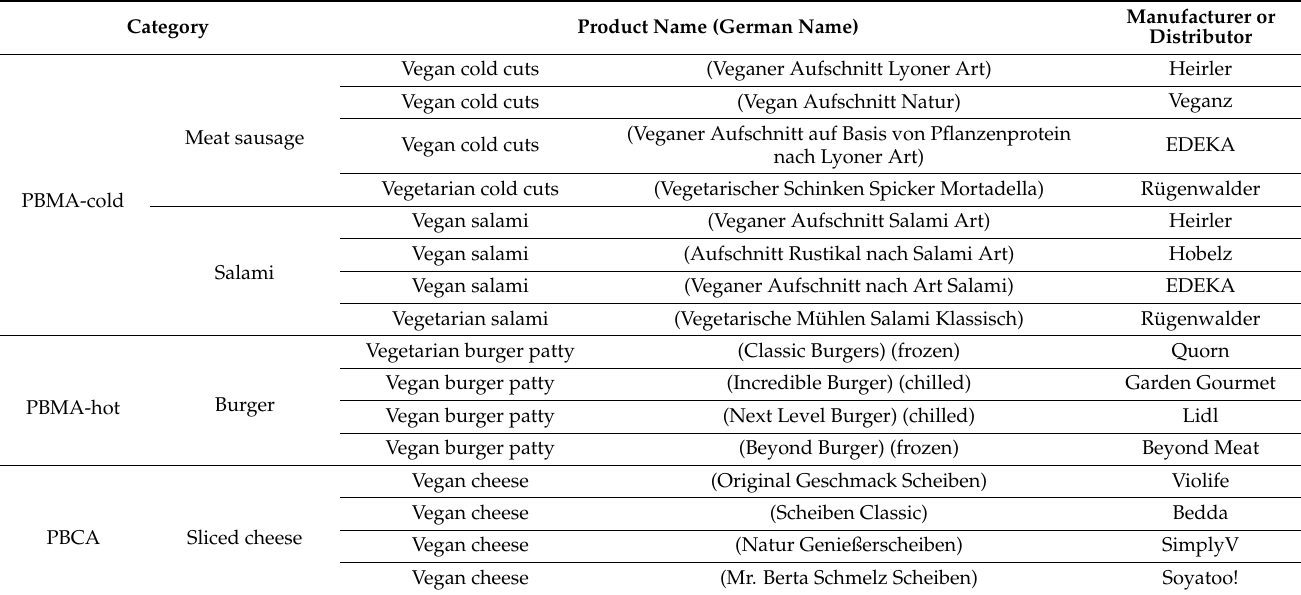
Table 2. Pb products for vitamin and mineral